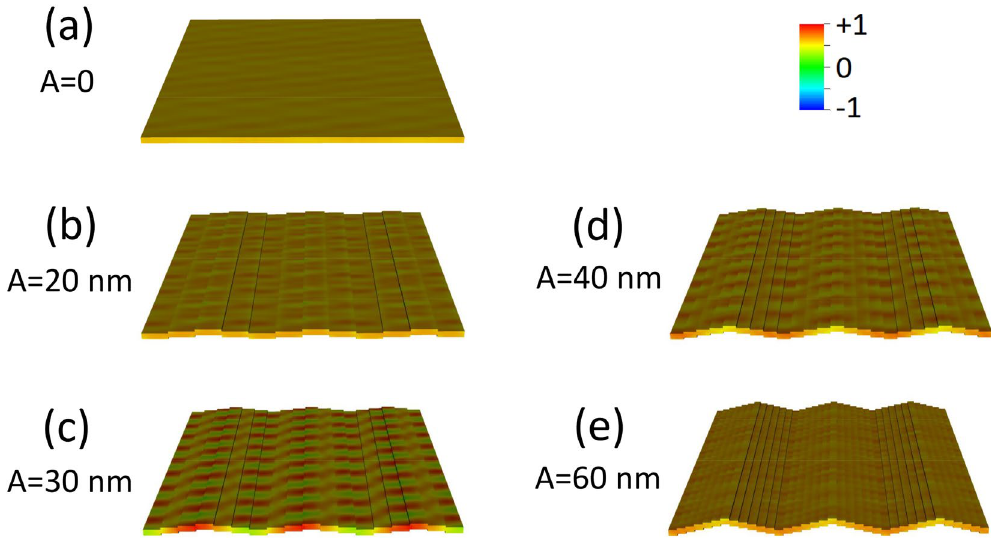
Figure 6. Real part of the out-of-plane (z) dynamic magnetization phase profile (colormap in arbitrary units) for k = 0, in configuration M (cid:31) y , for increasing undulation amplitude A , shown in perspective to highlight the involvement of the third dimension: (a) planar film with 30 nm thickness, i.e., . A = 0; (b) 4-layer system, i.e. A = 20 nm; (c) 6-layer system, i.e., A = 30 nm; (d) 8-layer system, i.e., A = 40 nm; (e) 12-layer system, i.e., A = 60 nm. The apparent non-uniform phase profile of the cell function is an unavoidable computational effect, though the ideal result should be a uniform profile. Note that each map is a 3 × 3 repetition of the primitive cell, as an indicative extract of the ideally infinite system.